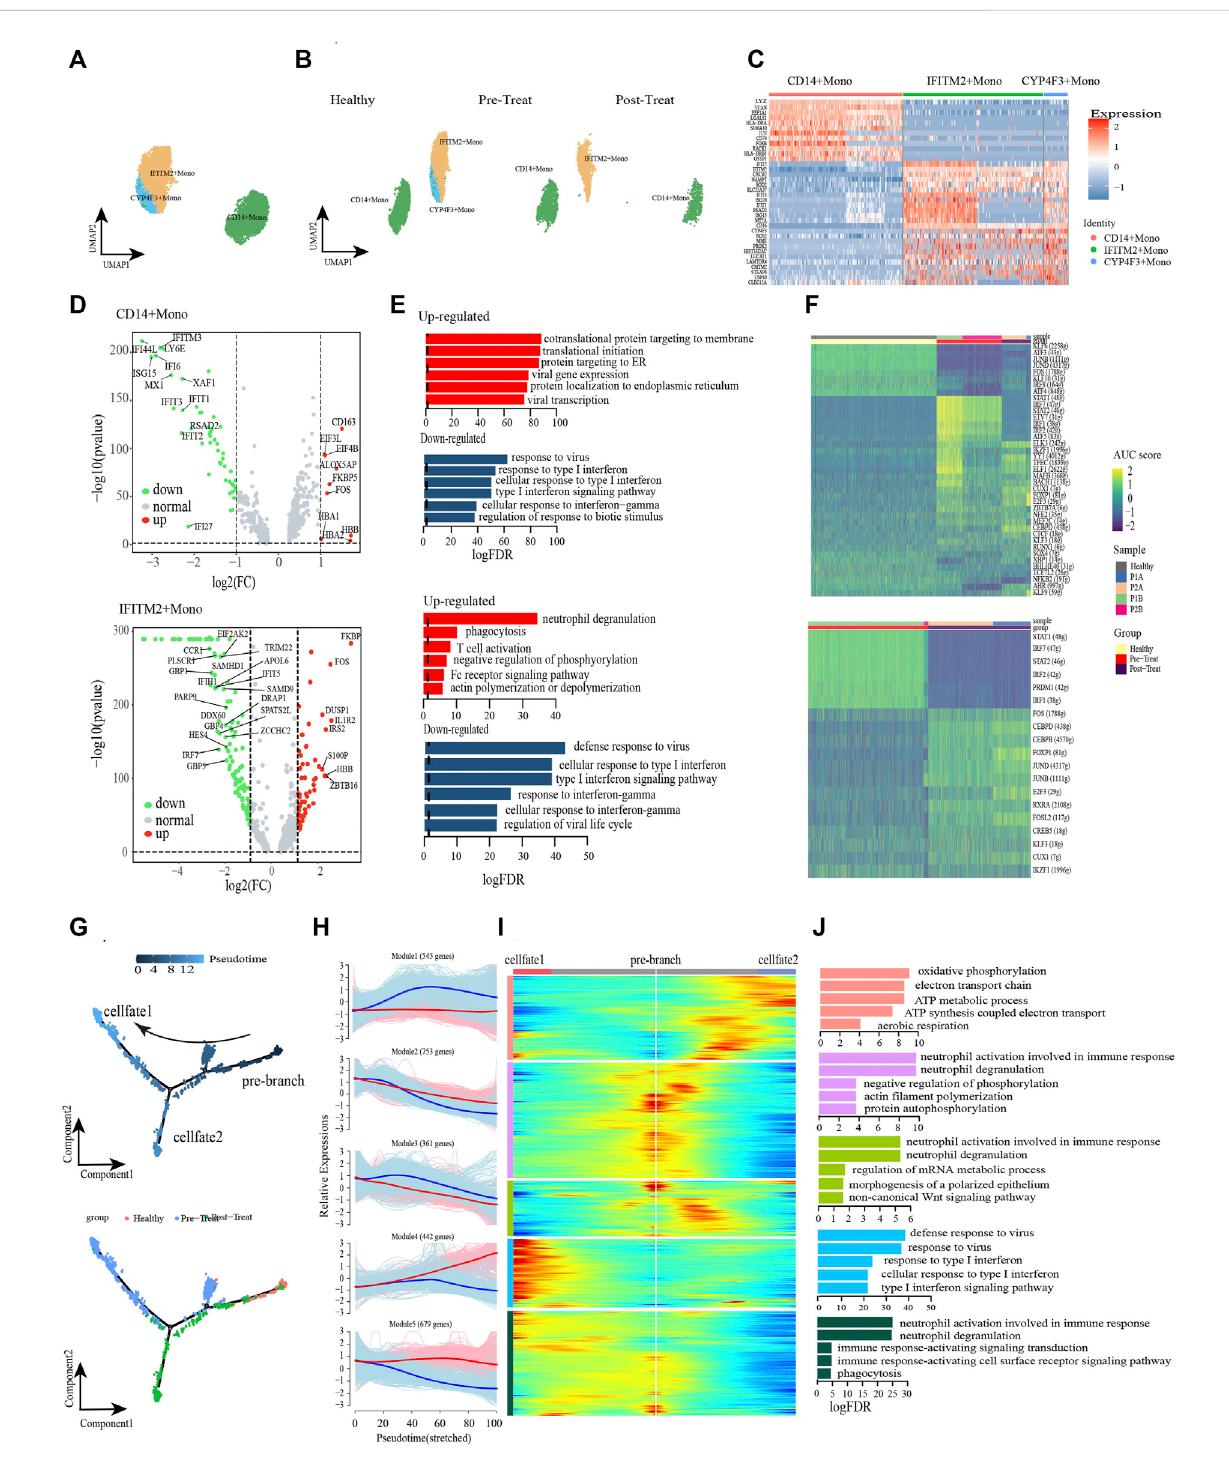
FIGURE 3 Classical monocytes were differentiated into non-classical monocytes in circulation of JDM patients. (A, B) Visualization of monocyte sub-clusters in human peripheral blood sample via Uniform Manifold Approximation and Projection (UMAP) plots by cell identity (A) and different stages (B) . (C) A heatmap shows the top marker genes of monocyte sub-clusters. (D) Volcano plot illustrating the representative differential genes between post-treat group and pre-treat group of CD14 + monocyte (up) and IFITM2+ monocyte (down). (E) GO enrichment of upregulated (red) and downregulated (blue)DEGsofCD14 + monocyte(up)andIFITM2+monocyte(down)inthepost-treatmentgroupcomparedtopre-treatgroup. (F) CD14 + monocyte(up) and IFITM2+ monocyte (down) subpopulation-speci fi c regulons identi fi ed via SCENIC analysis. (G) Pseudotime trajectory (Monocle analysis) of the monocyte. Cells are colored based according to the predicted pseudotime (top) and groups (bottom). (H) The expression dynamics of top DEGs were cataloged into fi ve major clusters in a pseudotime manner shown as red lines (cell fate 1) and blue lines (cell fate 2). (I) A heatmap shows the different expression patterns of top DEGs (cataloged in fi ve clusters) along the development of Cell fate1 and cell fate 2. (J) GO enrichment analyses of each gene